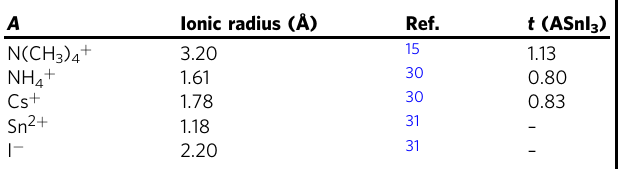
Table 2 Ionic radius of N(CH 3 ) 4 + , NH 4 + , Cs + , Sn 2 + , I − and the tolerance factor t of ASnI 3 ( A = N(CH 3 ) 4 + , NH 4 + , and Cs + ).